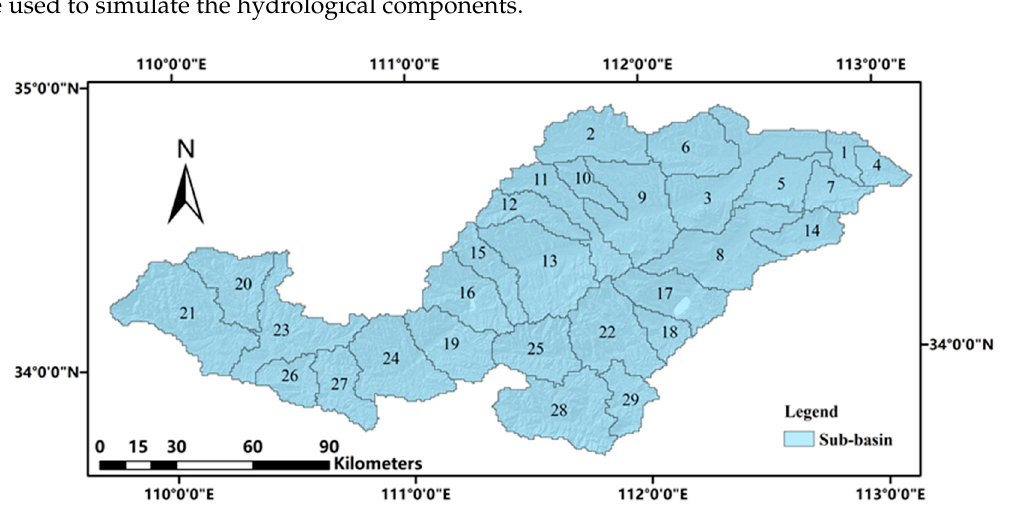
Figure 4. Sub-basins within the study area.